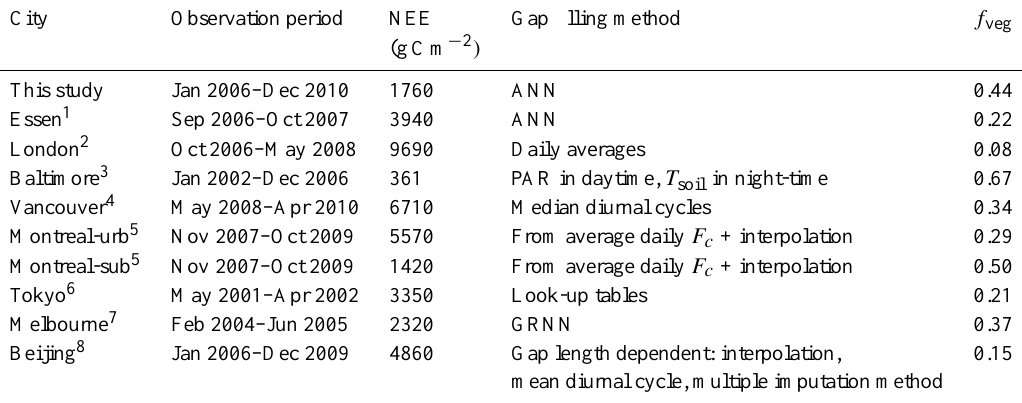
Table 4. Annual CO 2 emissions (NEE, gCm − 2 ) observed in urban studies and the methods used to obtain them. Only studies where more than 12 months have been reported are listed. Also the plan area fractions of vegetation ( f veg ) are